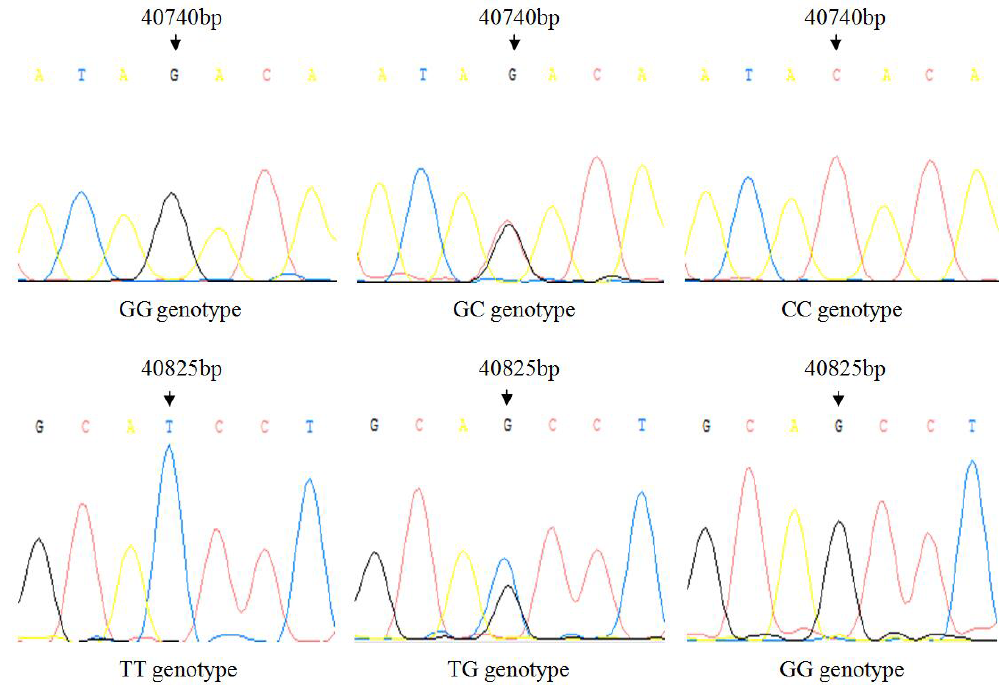
Figure 2. Sequencing results of three genotypes of two SNP